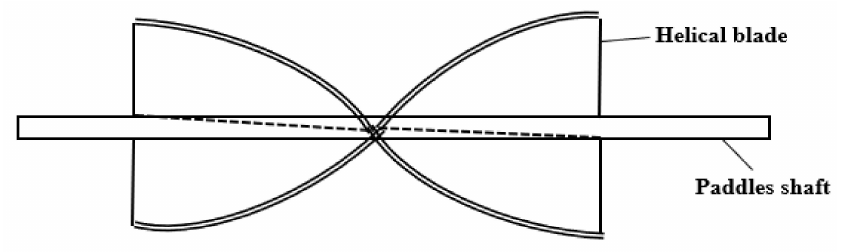
Figure 10. Helical paddle blades [59].